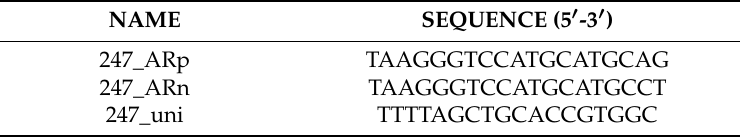
Table 2. Primers used for the DNA amplification of sterlet and Russian